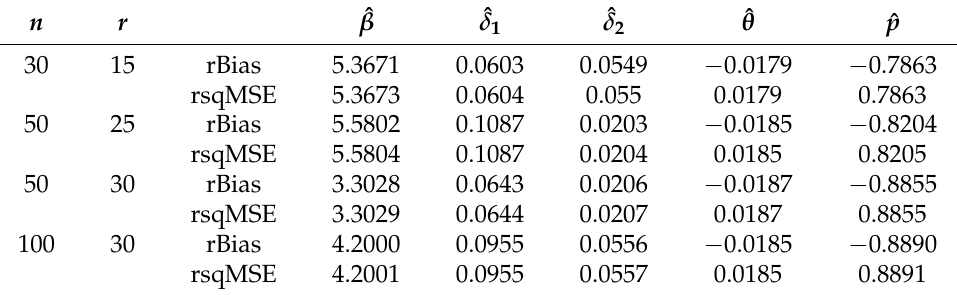
Table 6. The rBias and rsqMSE of maximum likelihood estimates (MLEs) for p = 0.2.